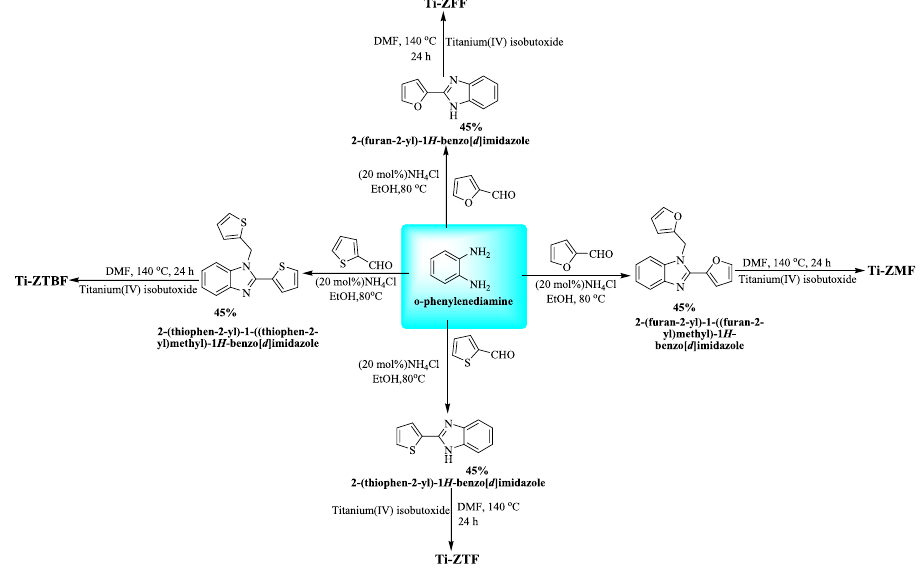
Figure 1. Synthesis of different ligands and Ti-based zeolitic imidazolate